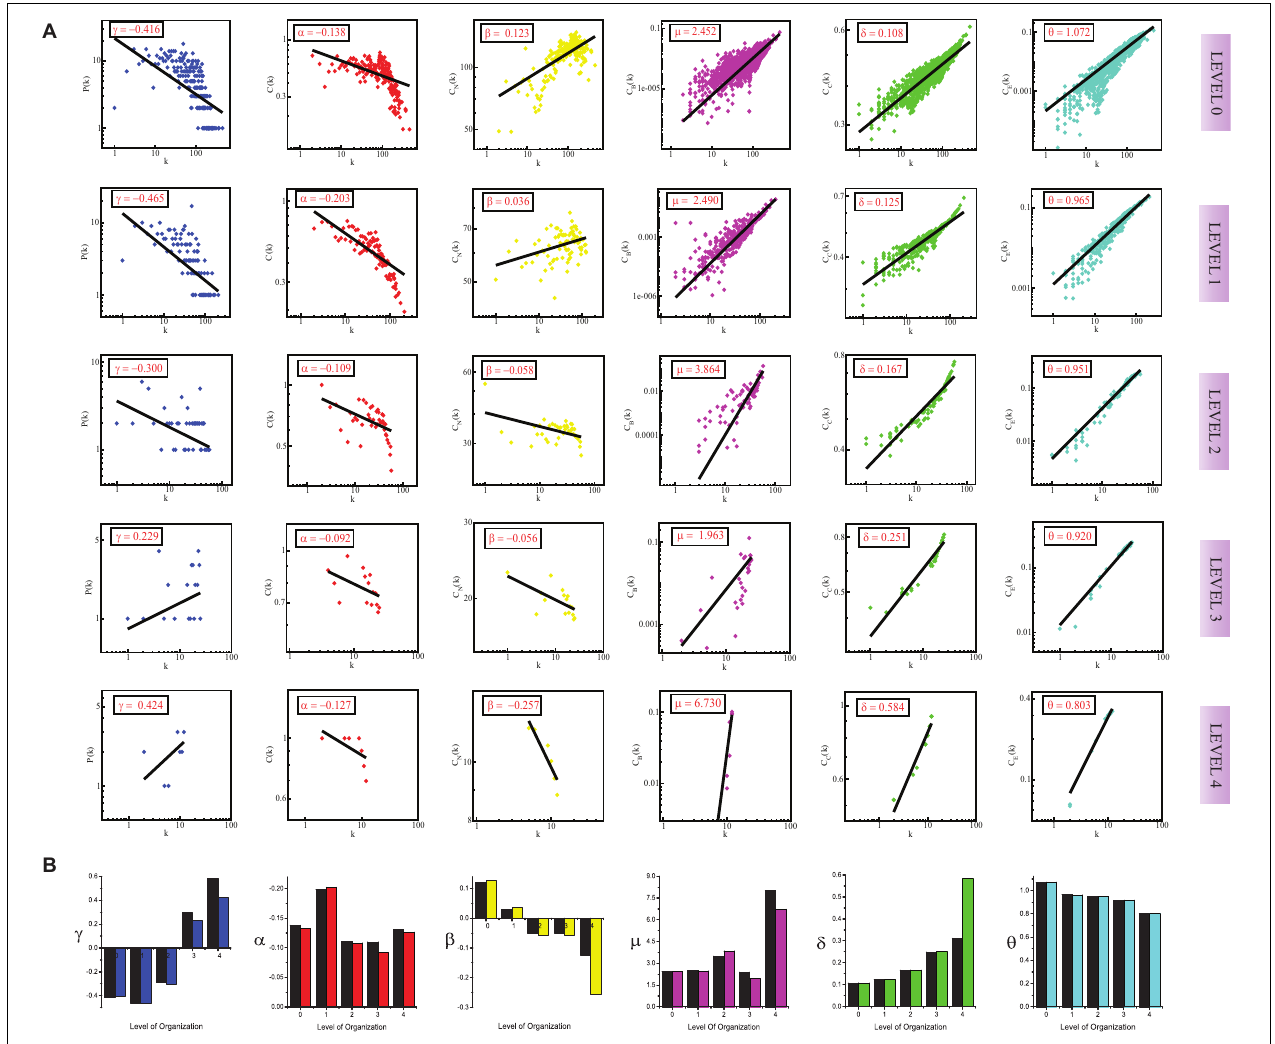
FIGURE 1 | (A) showing probability of degree distribution P ( k ), clustering coefficient C ( k ), neighborhood connectivity C N ( k ), betweenness centrality C B ( k ), closeness centrality C C ( k ), and eigenvector centrality C E ( k ) as a function of degree ( k ) for primary original network (level 0) and TNIP1 motif knockout networks at different levels of the organization (level 1–4). (B) showing changes in the values of the topological properties’ exponents of the TNIP1 motif knockout networks (colors corresponding to the ones used in the topological properties plots i.e., blue for P ( k ), red for C ( k ), yellow for C N ( k ), magenta for C B ( k ), green for C C ( k ) and turquoise for C E ( k )) compared with the topological properties’ exponents of the corresponding original networks (black) at different levels of the organization. γ , α , β , µ , δ , and O are the exponents of the degree distribution, clustering coefficient, neighborhood connectivity, betweenness centrality, closeness centrality, and eigenvector centrality,